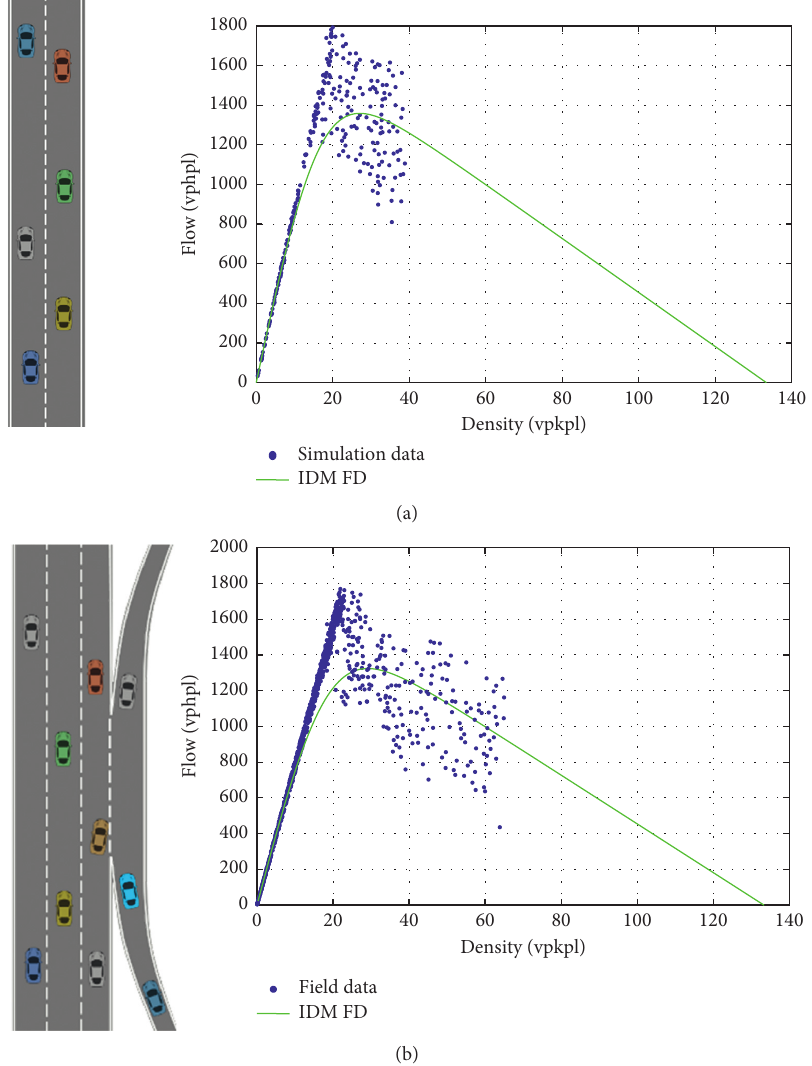
Figure 2: Resulting fundamental diagrams by the macroscopic IDM from (a) simulation data and (b) empirical